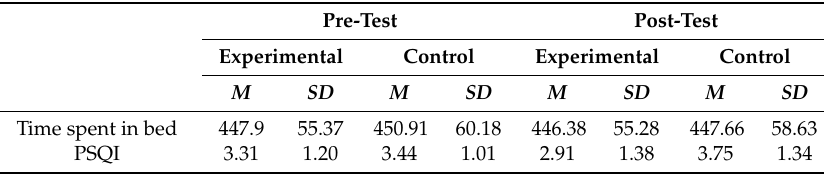
Table 1. Descriptive statistics for subjective